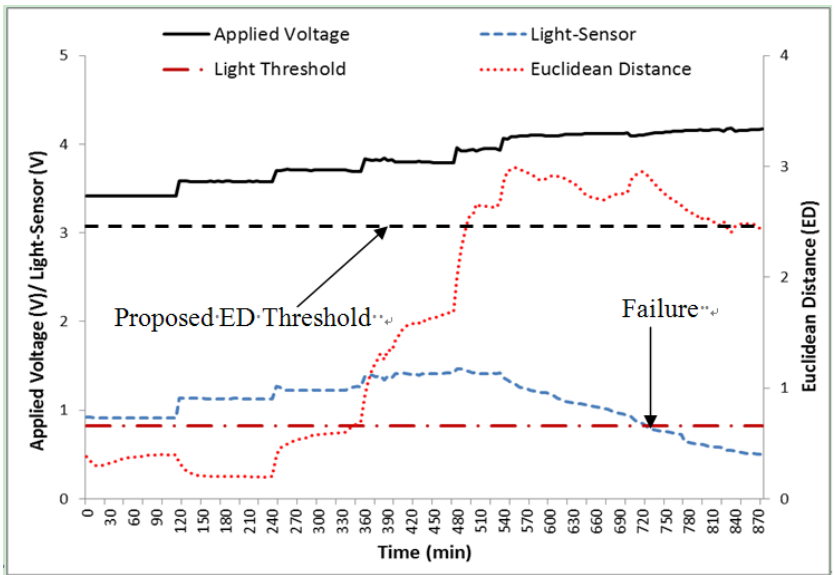
Figure 11. Euclidean Distance analysis for sensor